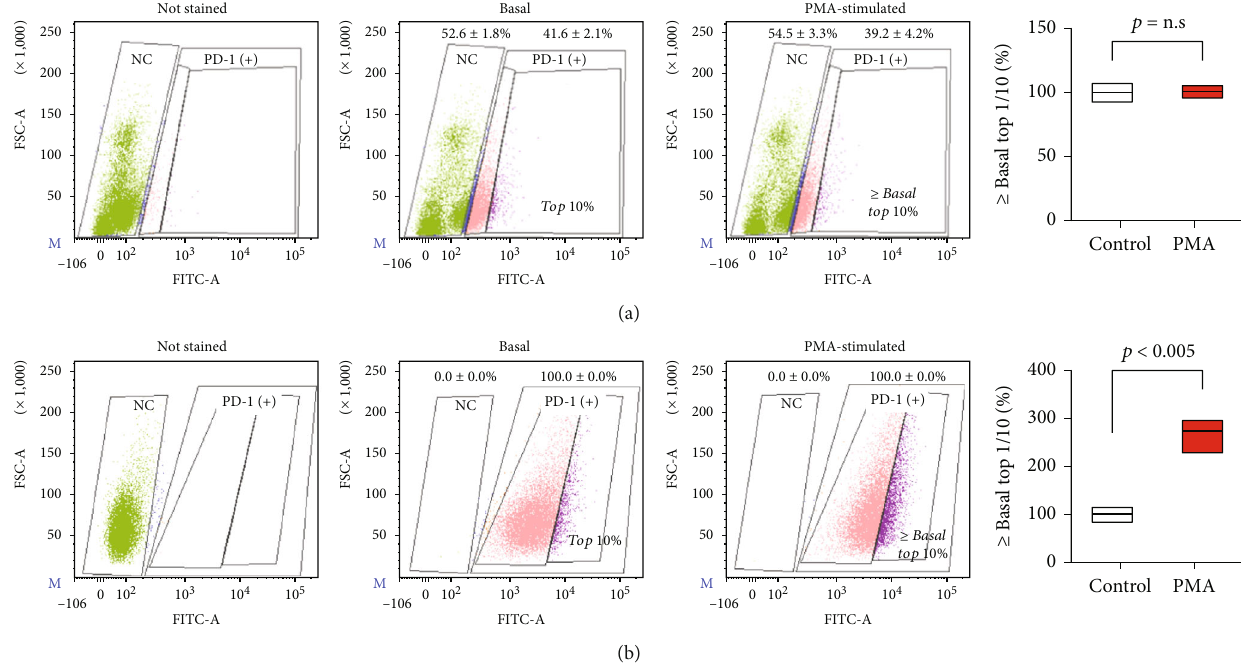
Figure 4: PD-1 expression on mouse lymphocytes and EL4 cells before and after PMA stimulation. Flow cytometry analysis of PD-1 expression on mouse splenic lymphocytes (a) and EL4 lymphoma cells (b). PMA stimulation was performed by treatment with 100ng/ ml for 24h. Samples were assessed for PD-1+ rate and increase in proportion of cells with strong PD-1+ staining (upper 10% at baseline) before and after PMA stimulation. Graphs on the right hand illustrate the mean and SD of proportion of strong PD-1+ cells obtained from triplicate samples per